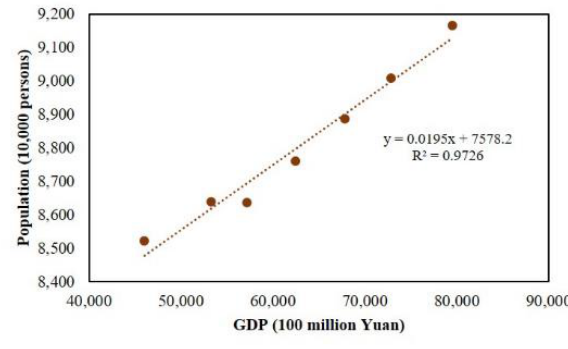
Figure 5. The correlation between gross domestic product (GDP) and population (2010 −